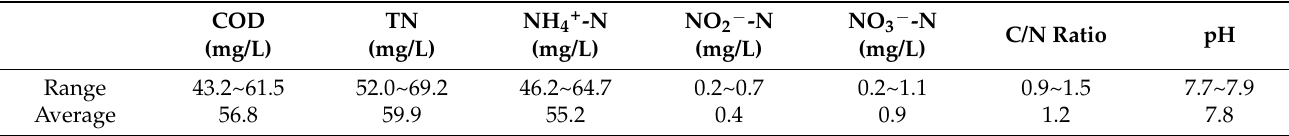
Table 1. Characteristics of the domestic sewage after aerating.